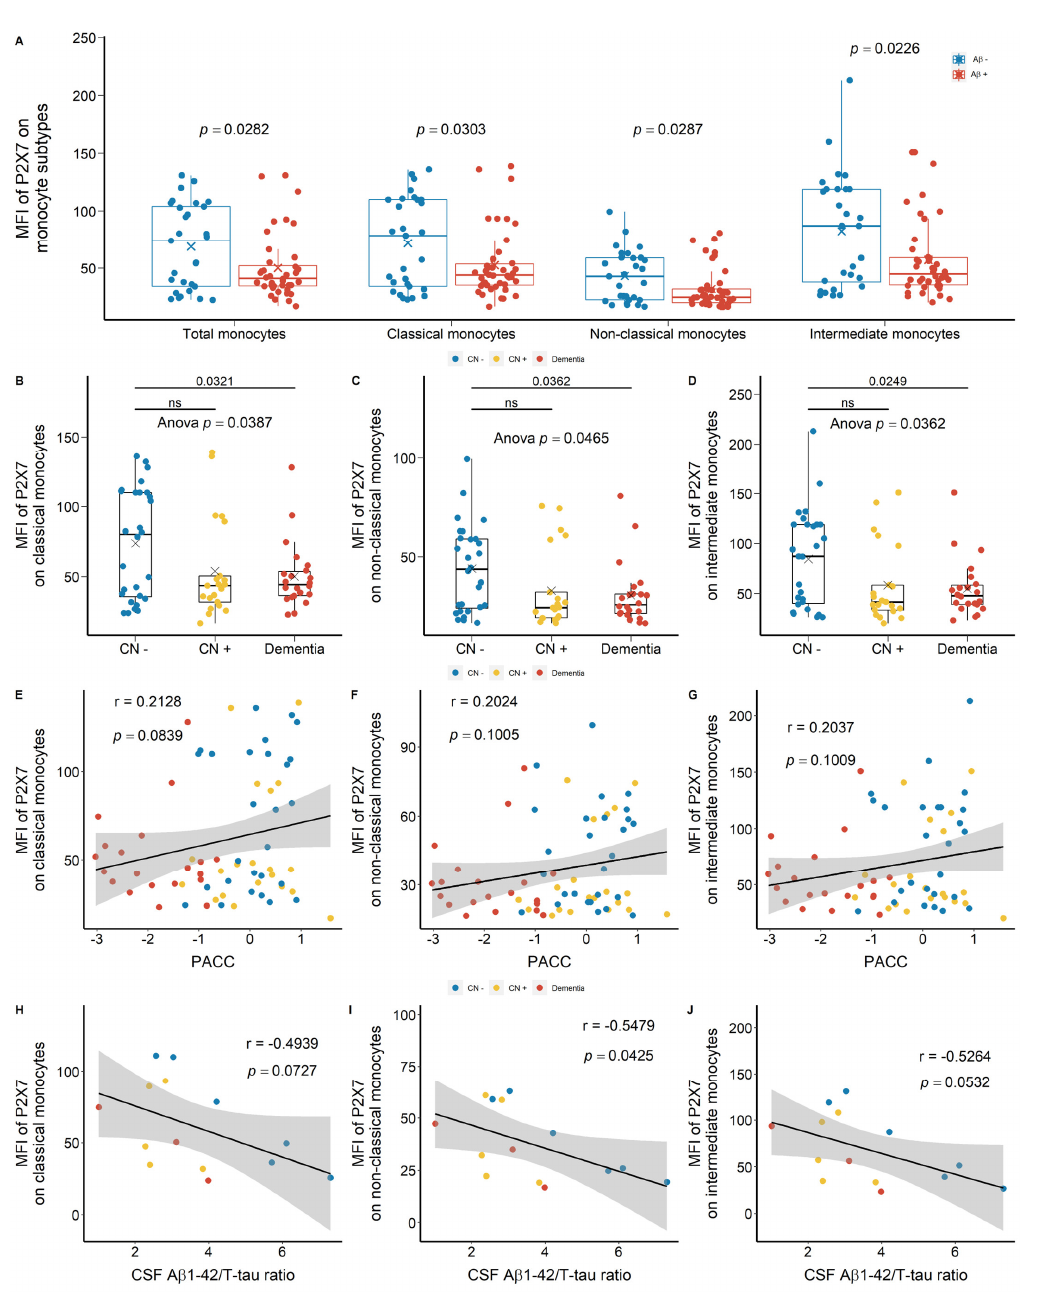
Figure 1. P2X7 expressions on monocytes in the discovery cohort. ( A ) P2X7 expressions on total monocytes ( left 1 ), CD14 + CD16 − classical monocytes ( left 2 ), CD14 dim CD16 + non-classical monocytes ( right 2 ), and CD14 + CD16 + intermediate monocytes ( right 1 ) between A β − ve controls (A β − ) and A β +ve cases (A β +). Bar graphs illustrated the boxplot distribution of individual measurements with “x” denoting the mean. Two group comparison was determined by t -test. ( B – D ) P2X7 expressions on classical monocytes, non-classical monocytes, and intermediate monocytes between CN (CN − : CN − ve), pre-clinical (CN+: CN +ve), and AD with dementia (Dementia: MCI +ve and AD) individuals. Bar graphs illustrated the boxplot distribution of individual measurements with “x” denoting the mean. Three-group comparison was determined by one-way ANOVA followed by multiple compari- son using Dunnett’s post-hoc test (solid line). ( E – J ) Associations between monocyte P2X7 expressions, PACC, and CSF biomarker. Correlation r and p values were calculated by Pearson product-moment correlational analysis. The “grey” band indicated the 95% confidence interval of the black linear regression line. ns: no